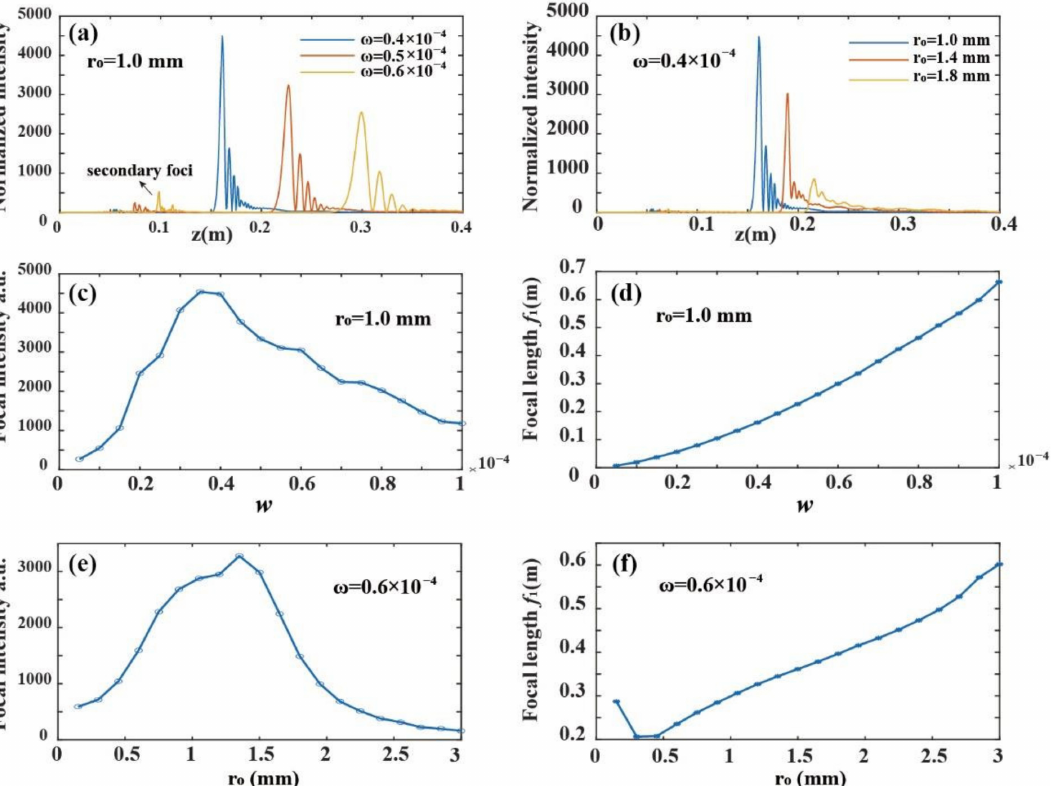
Figure 2. Adjustable focal length and focal intensity. ( a ) The peak intensity as a function of z with different w at r 0 = 1 mm; ( b ) The peak intensity as a function of z with different r 0 at w = 0.4 × 10 − 4 . ( c ) The focal intensity as a function of w . ( d ) The focal length as a function of w. ( e ) The focal intensity as a function of r 0 . ( f ) The focal length is a function of r 0 .